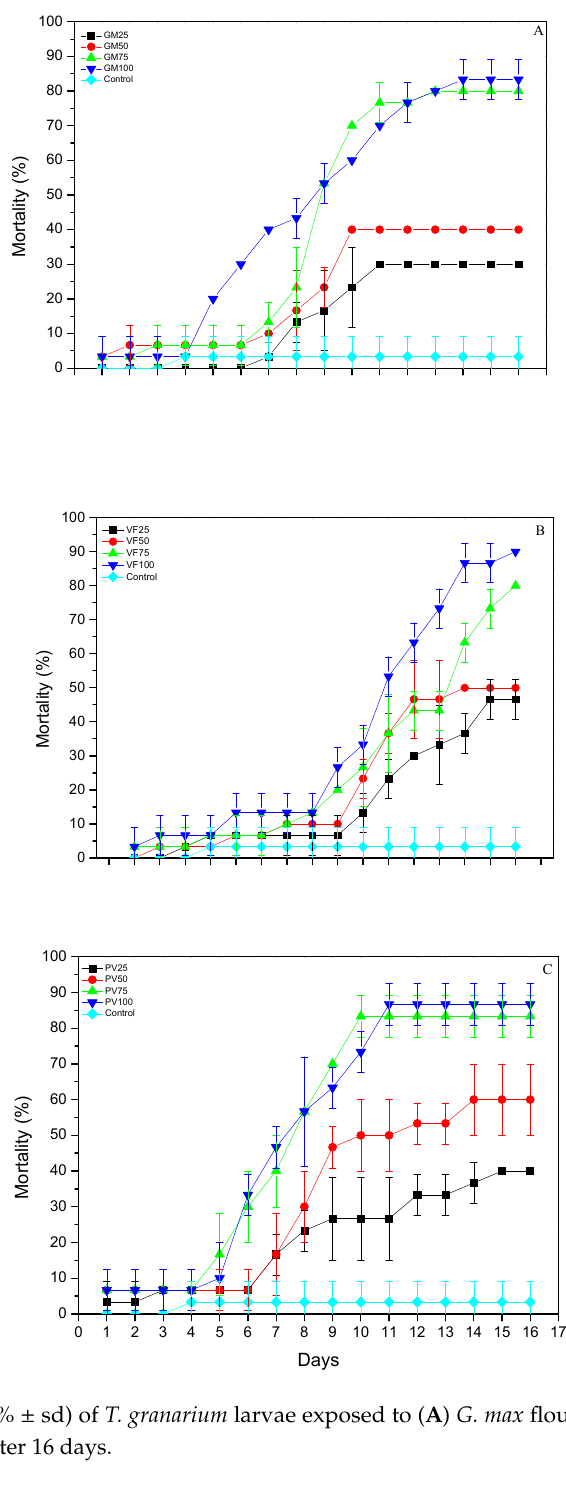
Figure 1. Mortality (% ± sd) of T. granarium larvae exposed to ( A ) G. max flour, ( B ) V. faba flour and ( C ) P. vulgaris flour after 16 days.